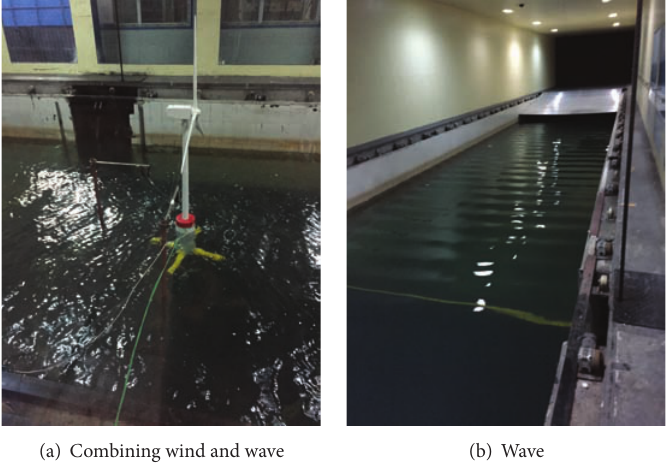
Figure 12: Model test process.